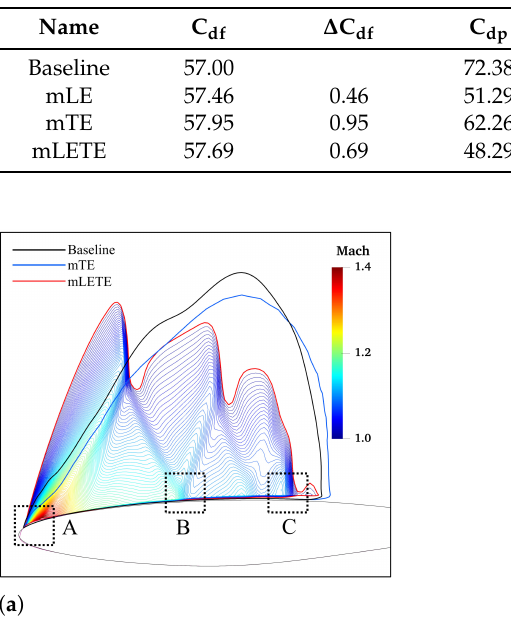
Table 3. Drag breakdown (counts).